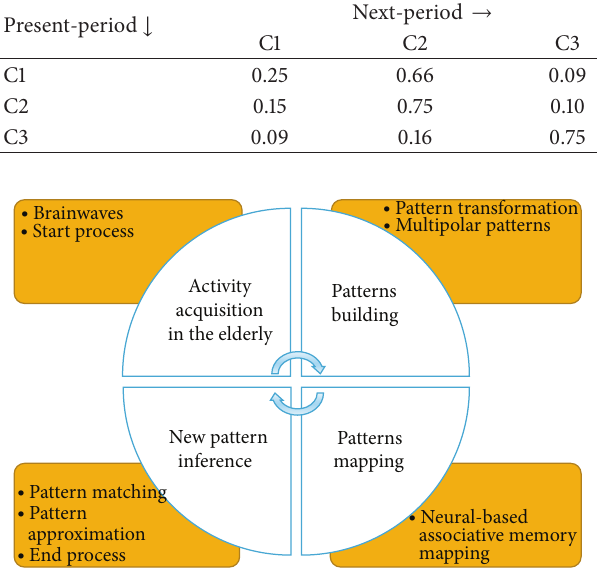
Figure 3: Pattern-inference cycle.